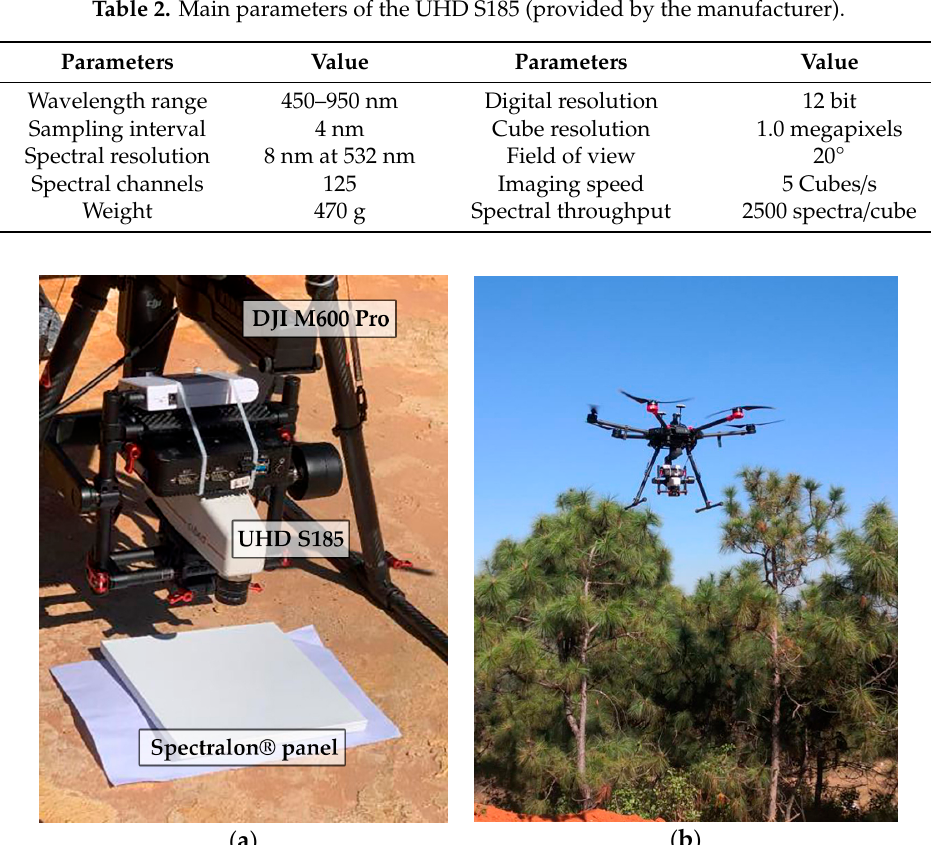
Figure 2. Unmanned aerial vehicle (UAV)-based hyperspectral acquisition equipment. ( a ) UHD S185, radiometric calibration. ( b ) The UAV took off and collected data.